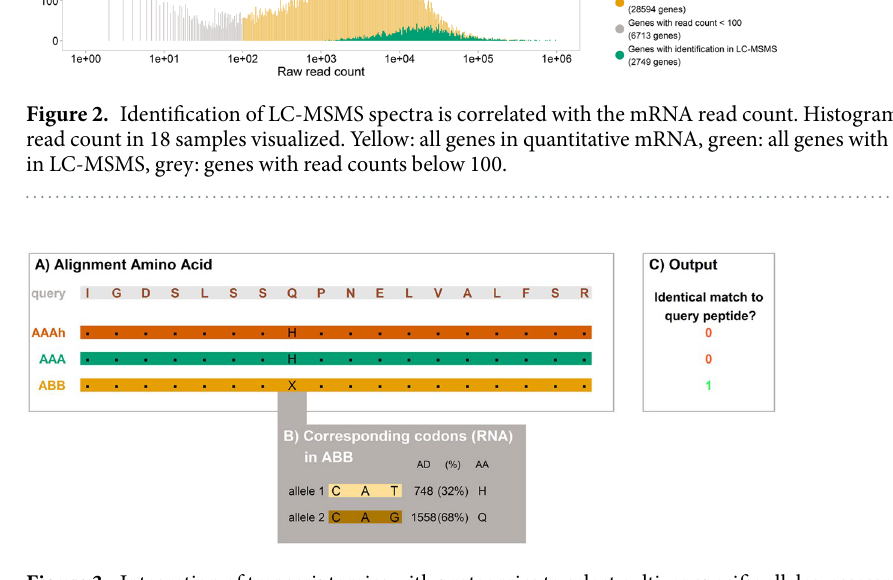
Figure 3. Integration of transcriptomics with proteomics to select cultivar specific alleles: assessment of aligned amino acid sequences and codons (RNA) reveals polymorphisms underlying the specific peptides. Exemplified for Ma02_t23730 (Sucrose Synthase 2). ( A ) Query peptide sequence identified in LC-MSMS (IGDSLSSQPNELVALFSR) aligned to AAA, AAAh, and ABB databases. ( B ) For the ambiguous amino acid in ABB database (X) the variants of the corresponding codon are assessed in the RNA database of the cultivar of interest. The allele depth (AD) of 1558 (68%) for allele 2 favors the presence of a unique amino acid (AA). ( C ) This is translated into specificity matching